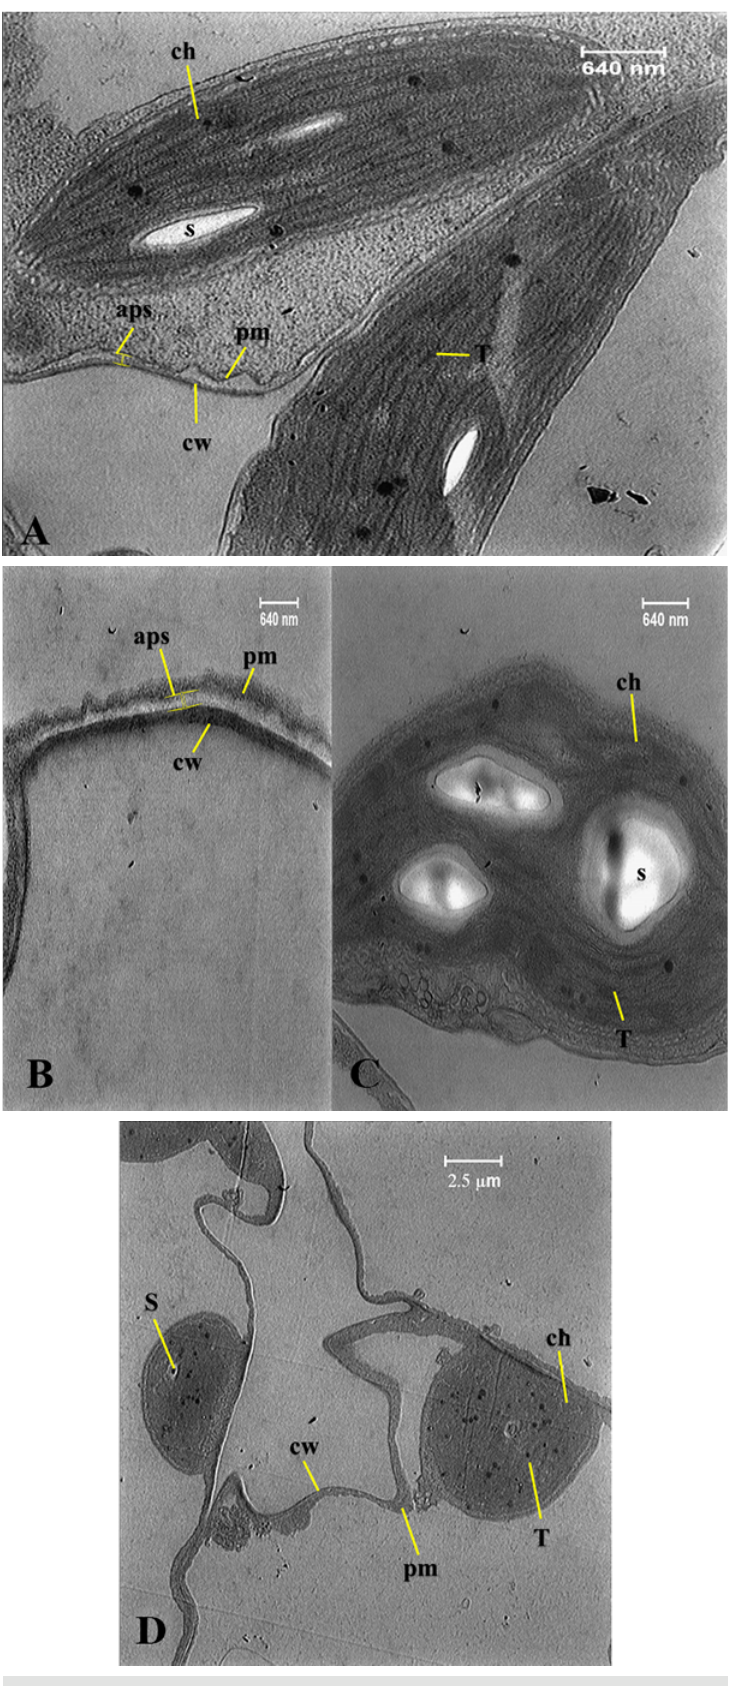
Fig. 1 Effect of treatments on the plant leaf’s ultrastructure in Portulaca oleracea L. ( A ) Control. ( B,C ) ZnO NPs 500 mg L −1 . ( D ) Bulk ZnO 500 mg L −1 . ch – chloroplast; T – thylakoid; S – starch; cw – cell wall; pm – plasma membrane; aps – apoplastic